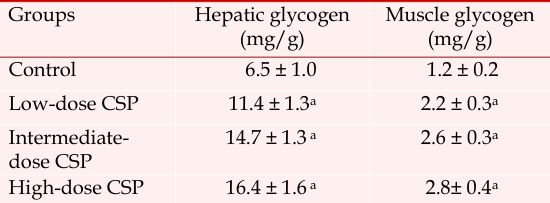
The effects of CSP on the hepatic glycogen and muscle glycogen levels of